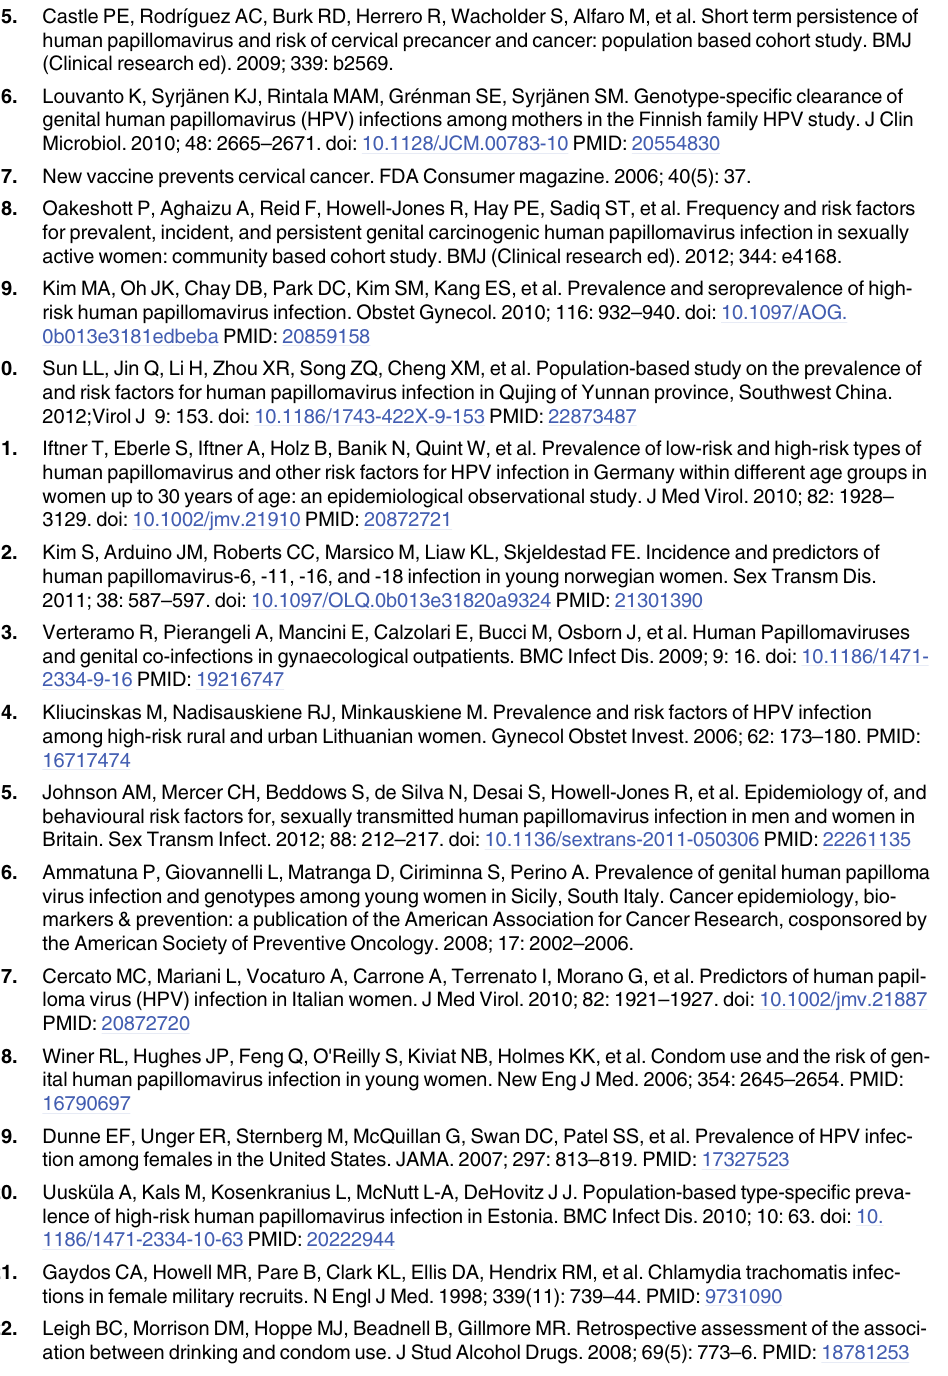
PLOS ONE | DOI:10.1371/journal.pone.0132462 July 15,